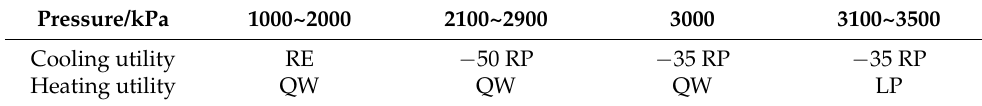
Table 5. The heating and cooling utilities in different pressure